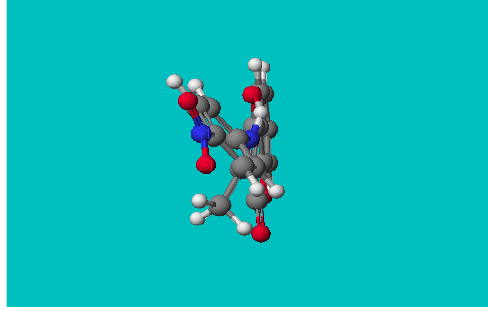
Figure 3. PM5 geometry of 4-hydroxy-3-(1-(4-nitrophenylimino)ethyl)-2H-chromen-2-one ( 13b ).